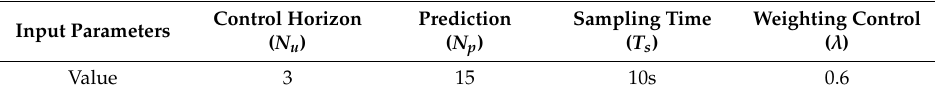
Table 1. Input tuning of the model predictive control (MPC) and GPC algorithms’ parameters.